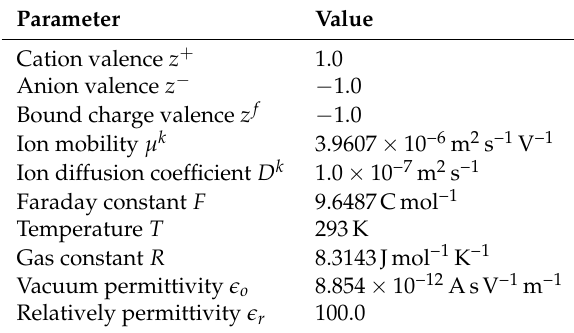
Figure 6. Electric potential: ( a ) 2D electrical stimulation, ( b ) comparison of chemical and electrical stimulation versus x -position at y = 0.0075m. Table 1. Simulation parameters used for simulations